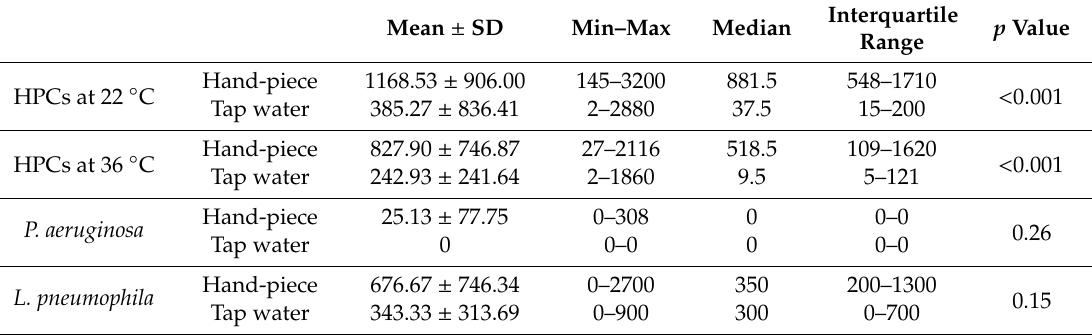
Interquartile p Value Range